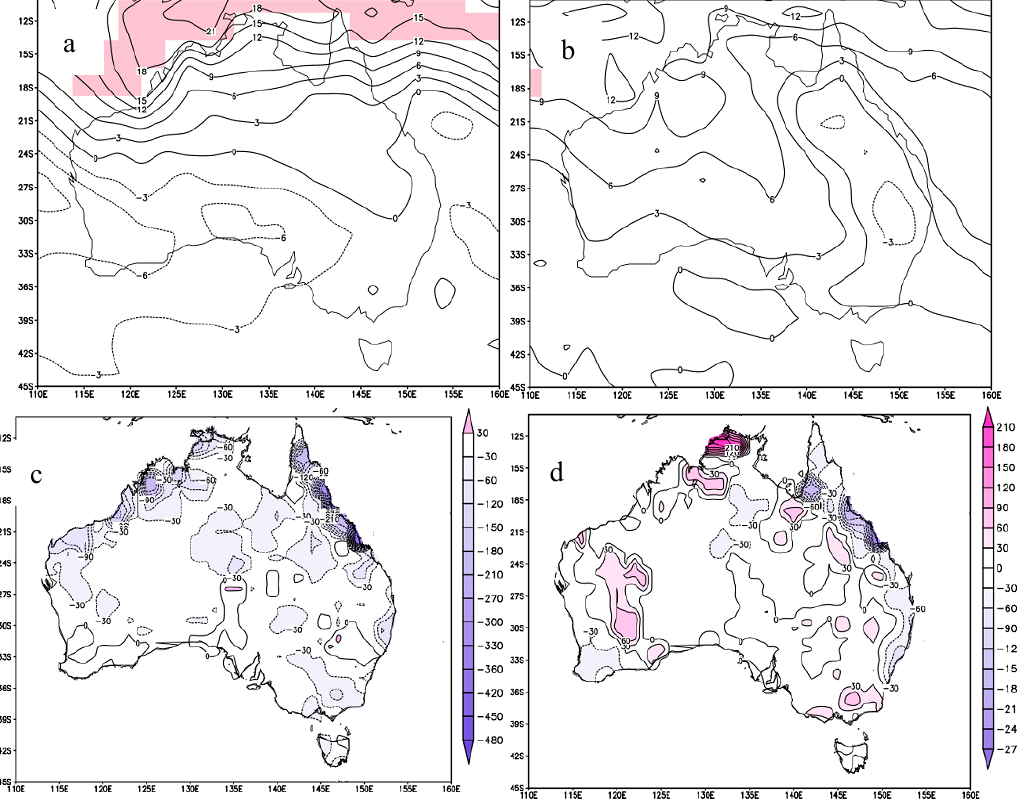
Figure 8. Composite outgoing longwave radiation (OLR) (units: W·m − 2 ) anomalies during DJF 1980–2017 for the austral ( a ) autumn and ( b ) winter El Niño events, the contour interval is 3 W·m − 2 . Shaded areas are statistically significant at the 95% confidence level, based on the Student’s t -test. ( c ) and ( d ) are the same as (a) and (b), but for summer rainfall anomalies, the contour interval is 30 mm.